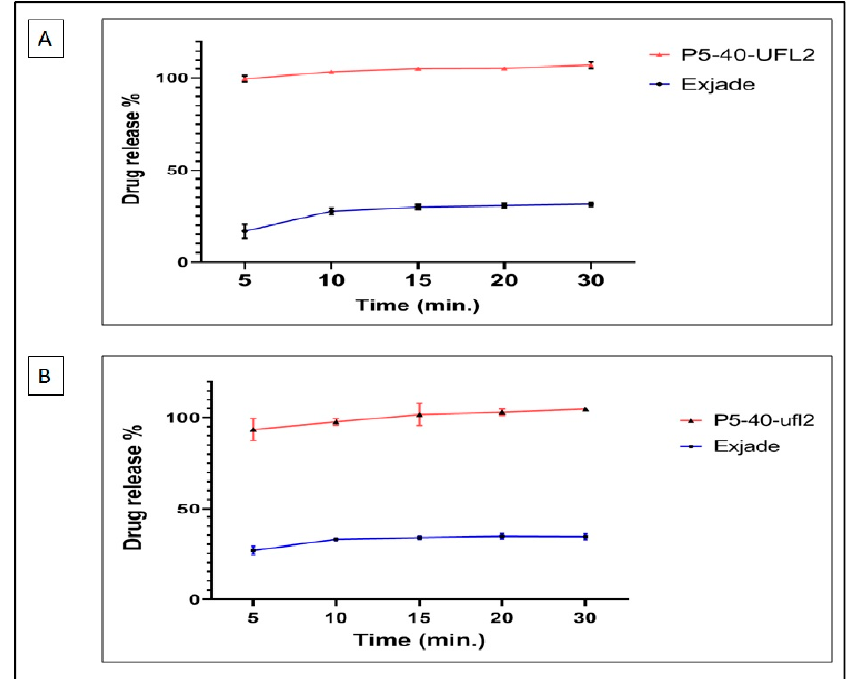
Figure 10. Drug release % of DFX from P5-40-UFL2 and its commercial tablet (Exjade ® ) in ( A ) phosphate buffer of pH 6.8 and ( B ) pH 1.2. The data represent drug release (%) versus time (in min) in terms of mean ± SD ( n = 3) ( p < 0.05).